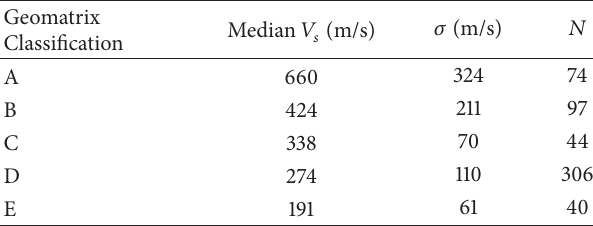
Table 1: Median 𝑉 𝑠30 and standard deviation for NGA database [10] profiles based on Geomatrix Classification